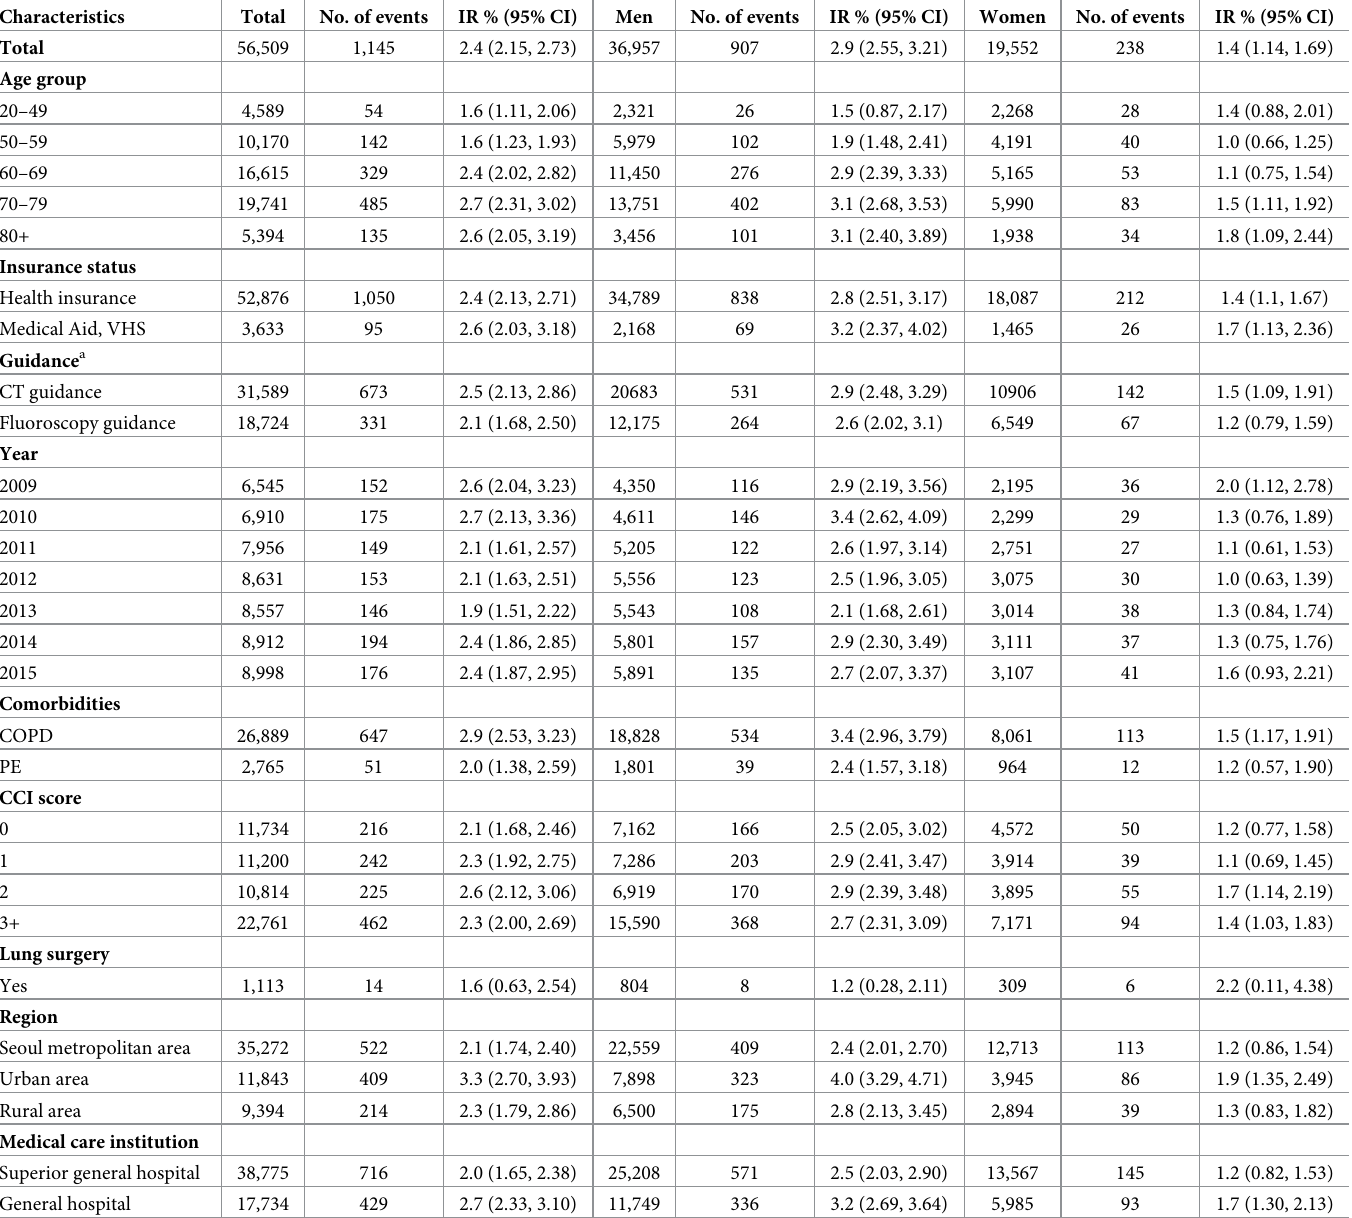
Table 2. Incidence rate of severe pneumothorax among patients who underwent percutaneous transthoracic needle biopsy of the lung.